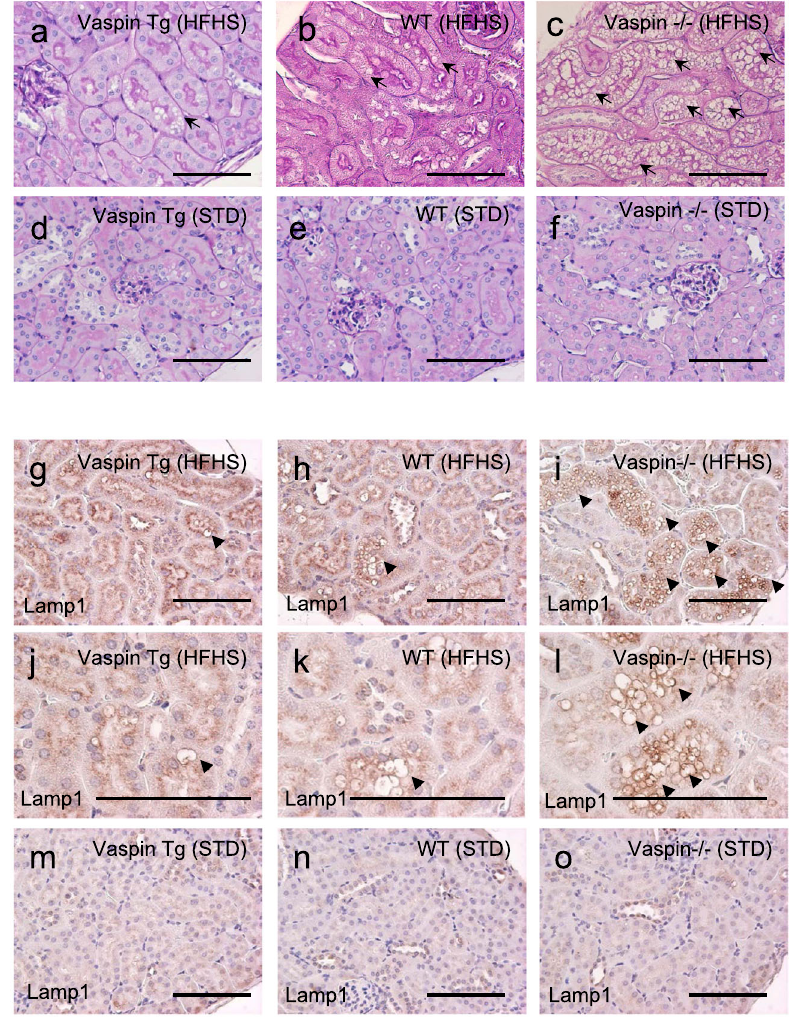
Fig. 1 Light microscopic photographs of Vaspin Transgenic (Tg), wild type (WT), Vaspin − / − mice under high fat-high sucrose (HFHS) diet, or standard diet (STD) at 30 weeks of age. Periodic Acid-Schiff staining of kidney tissues ( a – f ). In Vaspin − / − mice fed with HFHS diet, prominent vacuolations are observed in renal tubular cells ( c ), while they are ameliorated in Vaspin Tg mice ( a ). Vacuolations are shown by arrows. Immunohistological staining of lysosomal-associated membrane protein 1 (Lamp1) ( g – o ). These vacuoles are positive for lysosomal-associated membrane protein 1 (Lamp1). Lamp1-positive lysosomes are shown by arrow heads. In Vaspin − / − mice under HFHS diet, the number of large lysosomes is